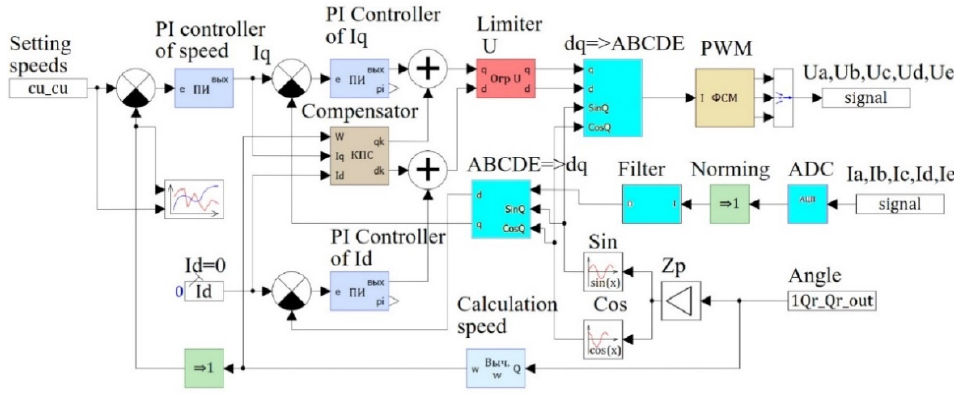
Figure 3. Simulation model of the control device. Table 1. Motor parameters.